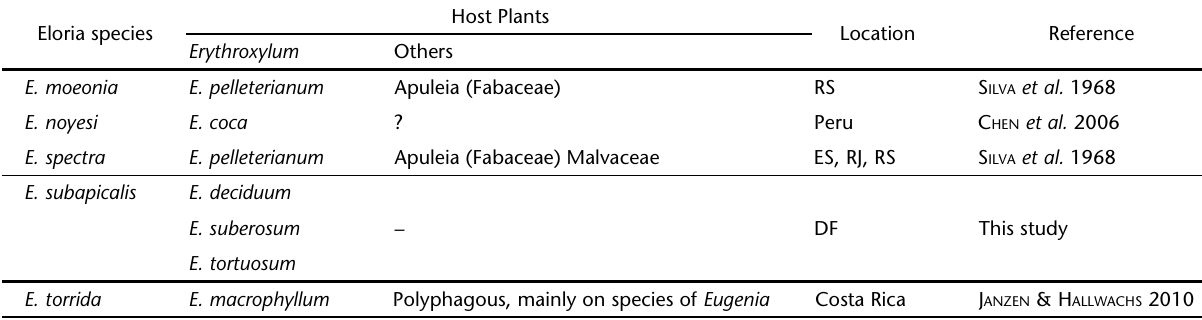
Table I. Available information on host plants of Eloria species. Eloria